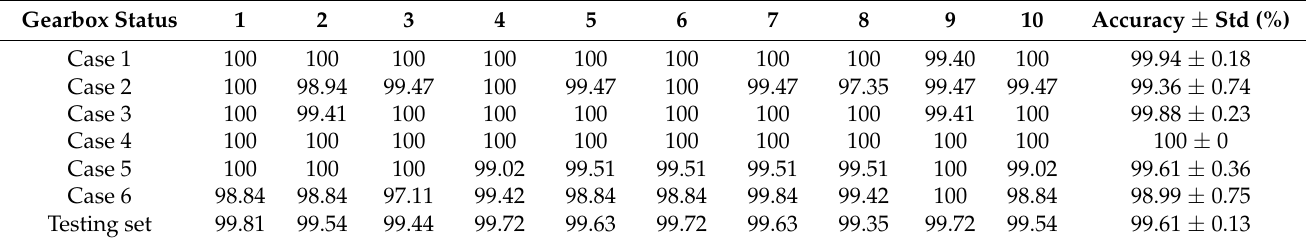
Table 10. Parallel experimental results of the CSAM-MSCNN.